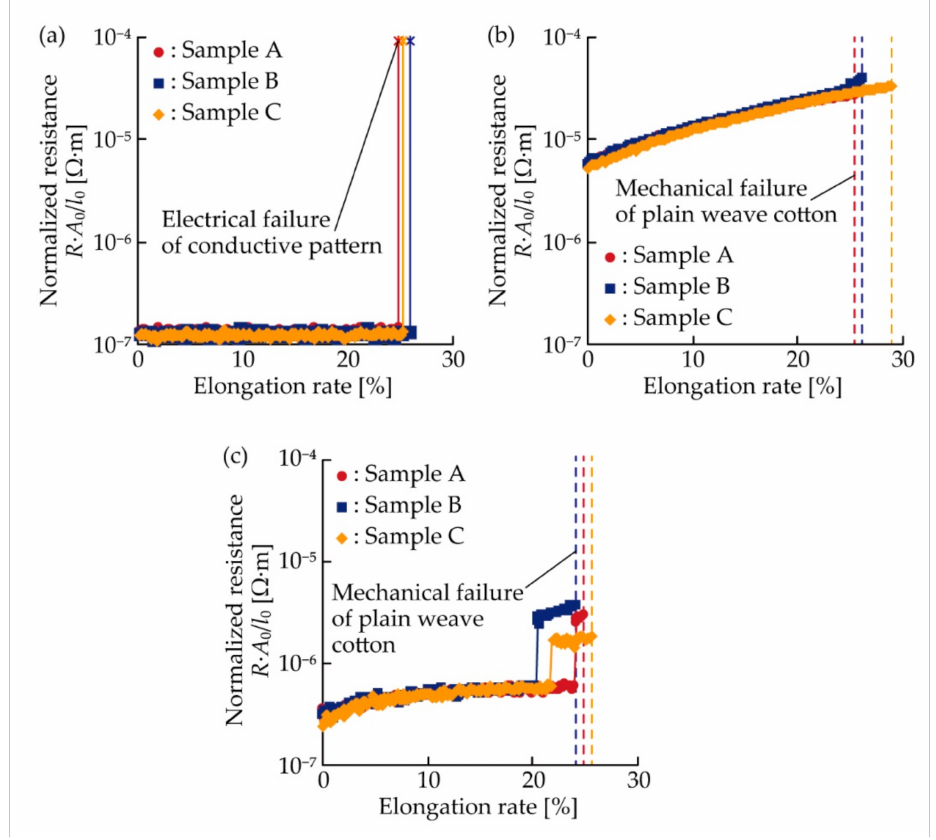
Figure 5. Normalized resistance plotted against the elongation rate for ( a ) meandering copper; ( b ) silver ink; and ( c ) double-layered patterns, under single tensile